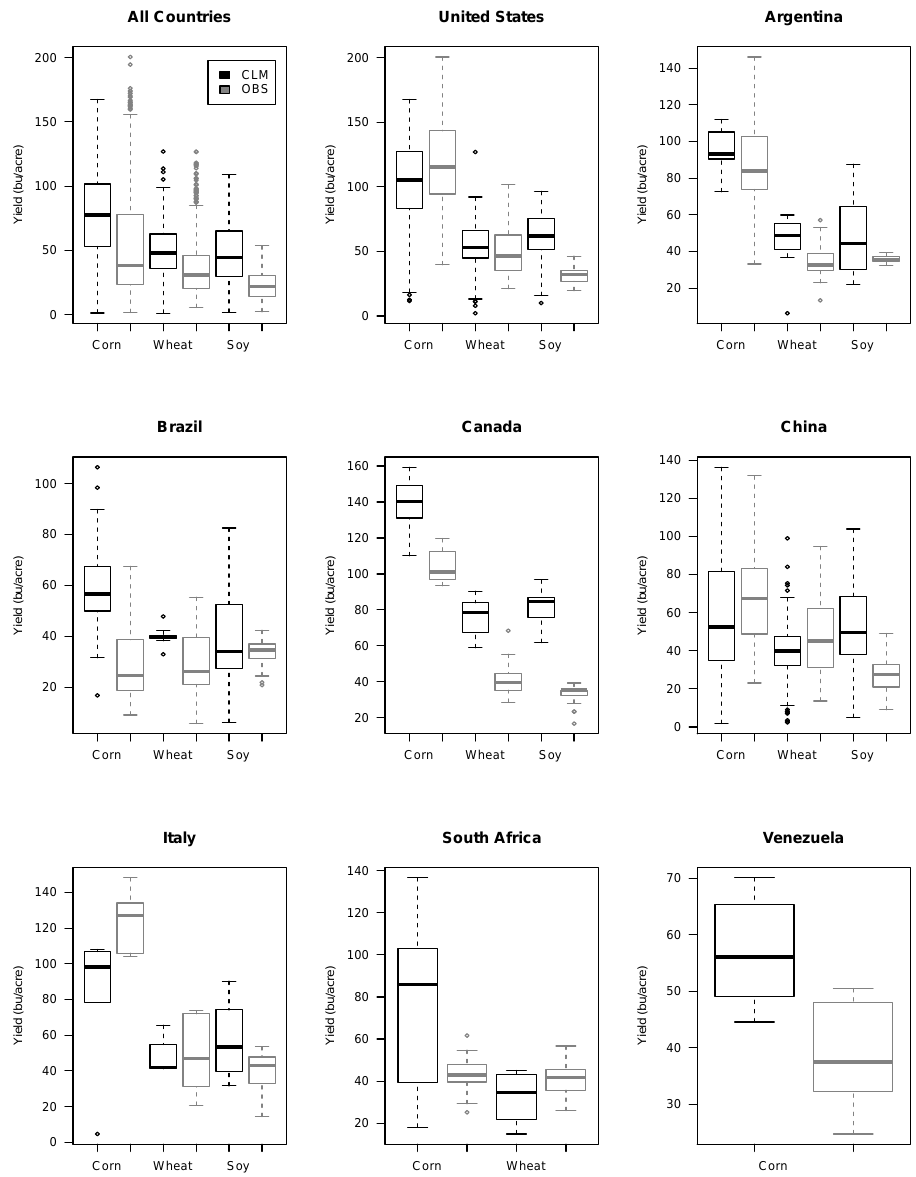
Fig. 8. CLM-Crop-simulated (black) and observed (gray; data from Monfreda et al., 2008) yields (bu acre − 1 ) for maize, wheat, and soybean of selected Figure 8. CLM-Crop-simulated (black) and observed (gray; data from Monfreda et al., 1016 2008) yield (bu acre -1 ) for maize, wheat, and soybean of selected regions. 1017